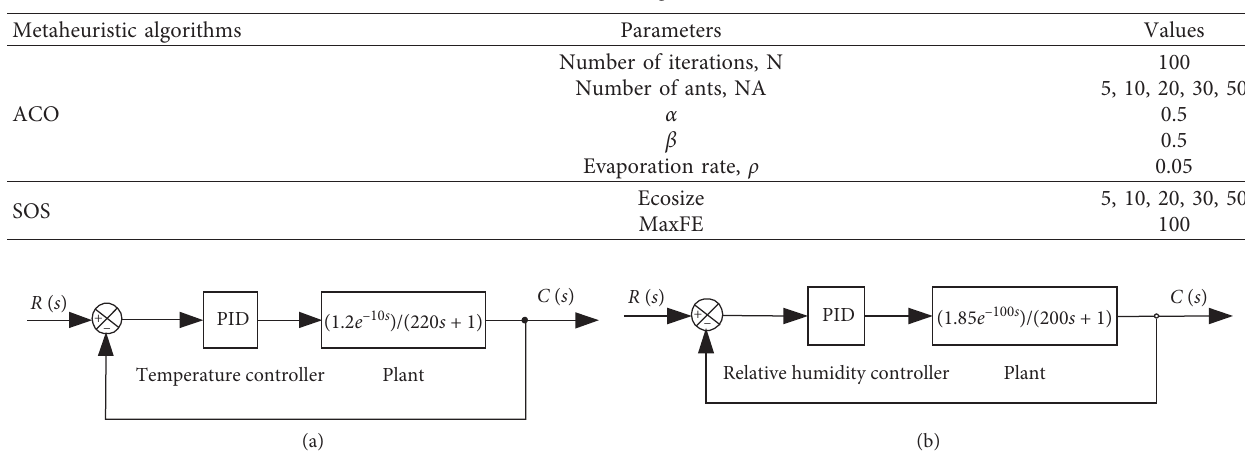
Figure 10: Experimental setting. (a) Comfortable room system. (b) PID control Table 3: Parameter setting of ACO and SOS.